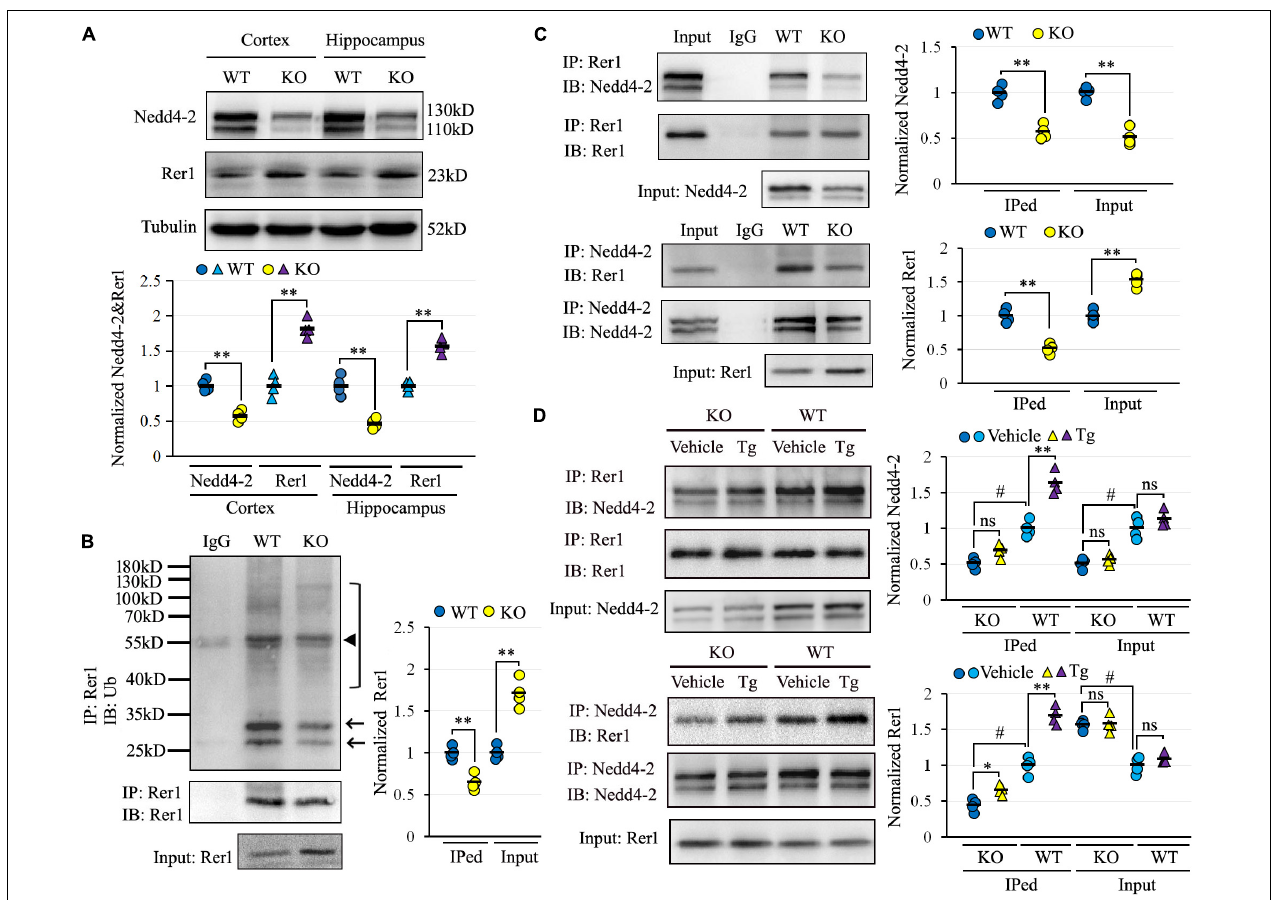
FIGURE 2 | Impaired Nedd4-2-mediated and ER stress-responsive ubiquitination of Rer1 in Nedd4-2 + / − mice. (A) Western blot analyses of Rer1 and Nedd4-2 in brain cortex and hippocampus of Nedd4-2 + / − (KO) and wild-type (WT) mice ( n = 4 in each group). ∗∗ P < 0.01 compared with WT controls by Student’s t -test. (B) Ubiquitination of Rer1 in mouse brain lysates immunoprecipitated with Rer1 antibodies and immunoblotted with ubiquitin antibodies ( n = 4 in each group). The arrows and bracket indicate the ubiquitinated Rer1. The triangle indicates the heavy chain of IgG. ∗∗ P < 0.01 compared with WT controls by Student’s t -test. (C) Co-immunoprecipitation (co-IP) analysis for the interaction of Rer1 and Nedd4-2 in mouse brain lysates ( n = 4 in each group). ∗∗ P < 0.01 compared with WT controls by Student’s t -test. (D) Co-IP analysis of Rer1 and Nedd4-2 in mice with 2 mg/kg ER stress inducer of Tg for 6 h ( n = 4 in each group). ns, not significant, ∗ P < 0.05, ** P < 0.01 compared with vehicle group; # P < 0.01 compared with WT group by post hoc Tukey’s